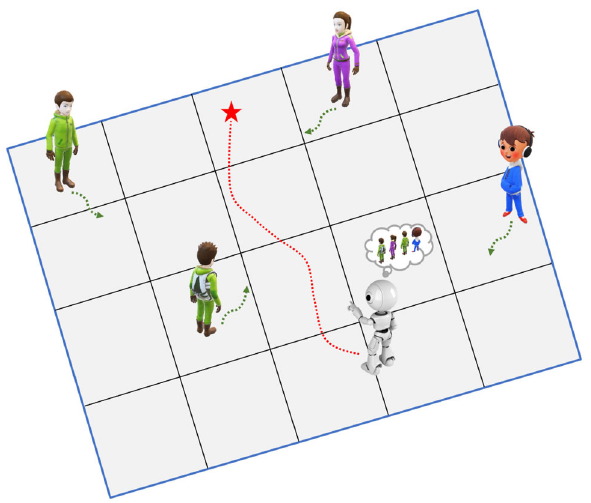
Fig. 1 Robot navigation in crowded environment using memory units for storing the relative importance and dependencies among humans